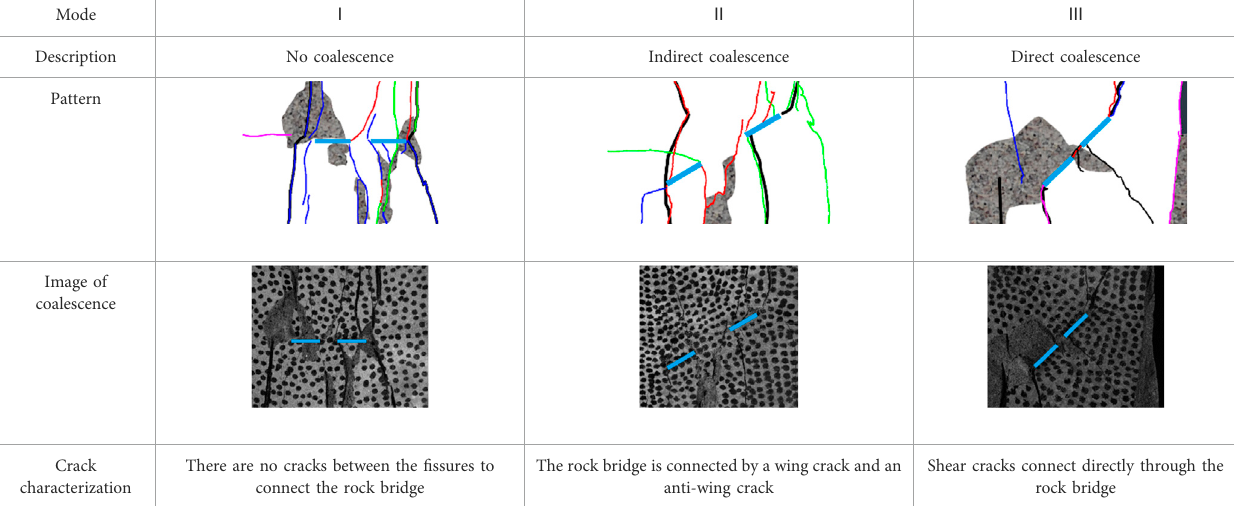
TABLE 2 Three kinds of rock bridges through modes of coplanar double- fi ssured sandstones.